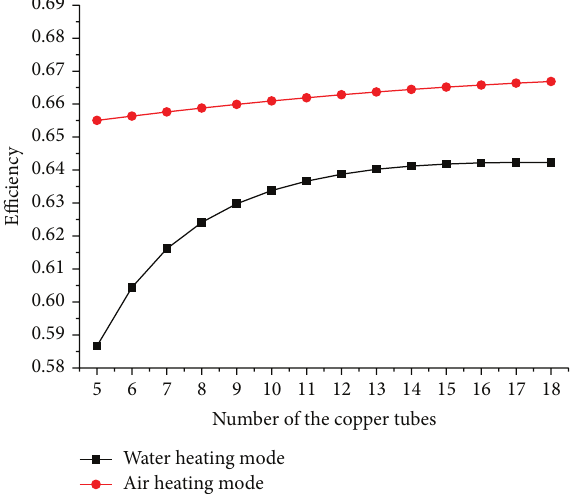
Figure 15: Effect of the number of copper tubes on efficiency of the collector in two working